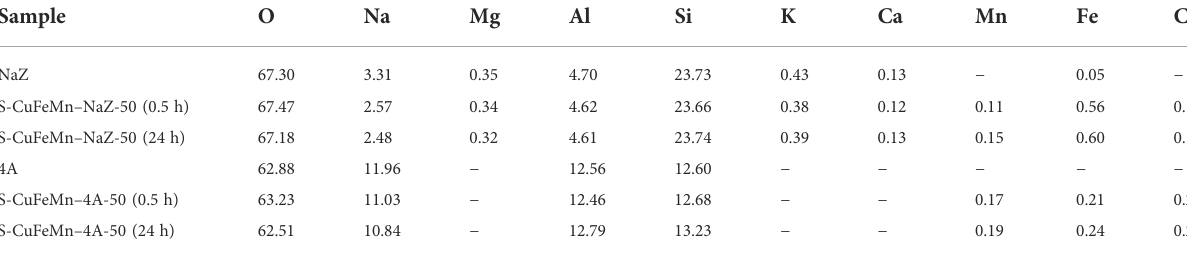
TABLE 2 An average elemental composition of selected samples obtained by the EDX analysis (in at%). Sample